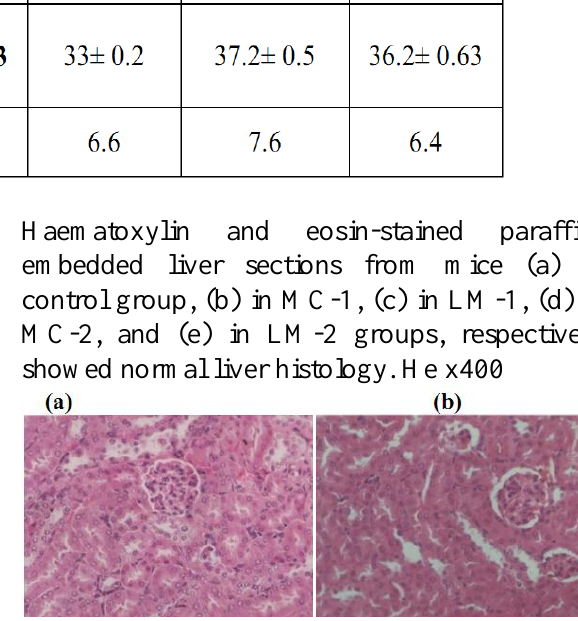
Figure 3. Kidney histopathology of